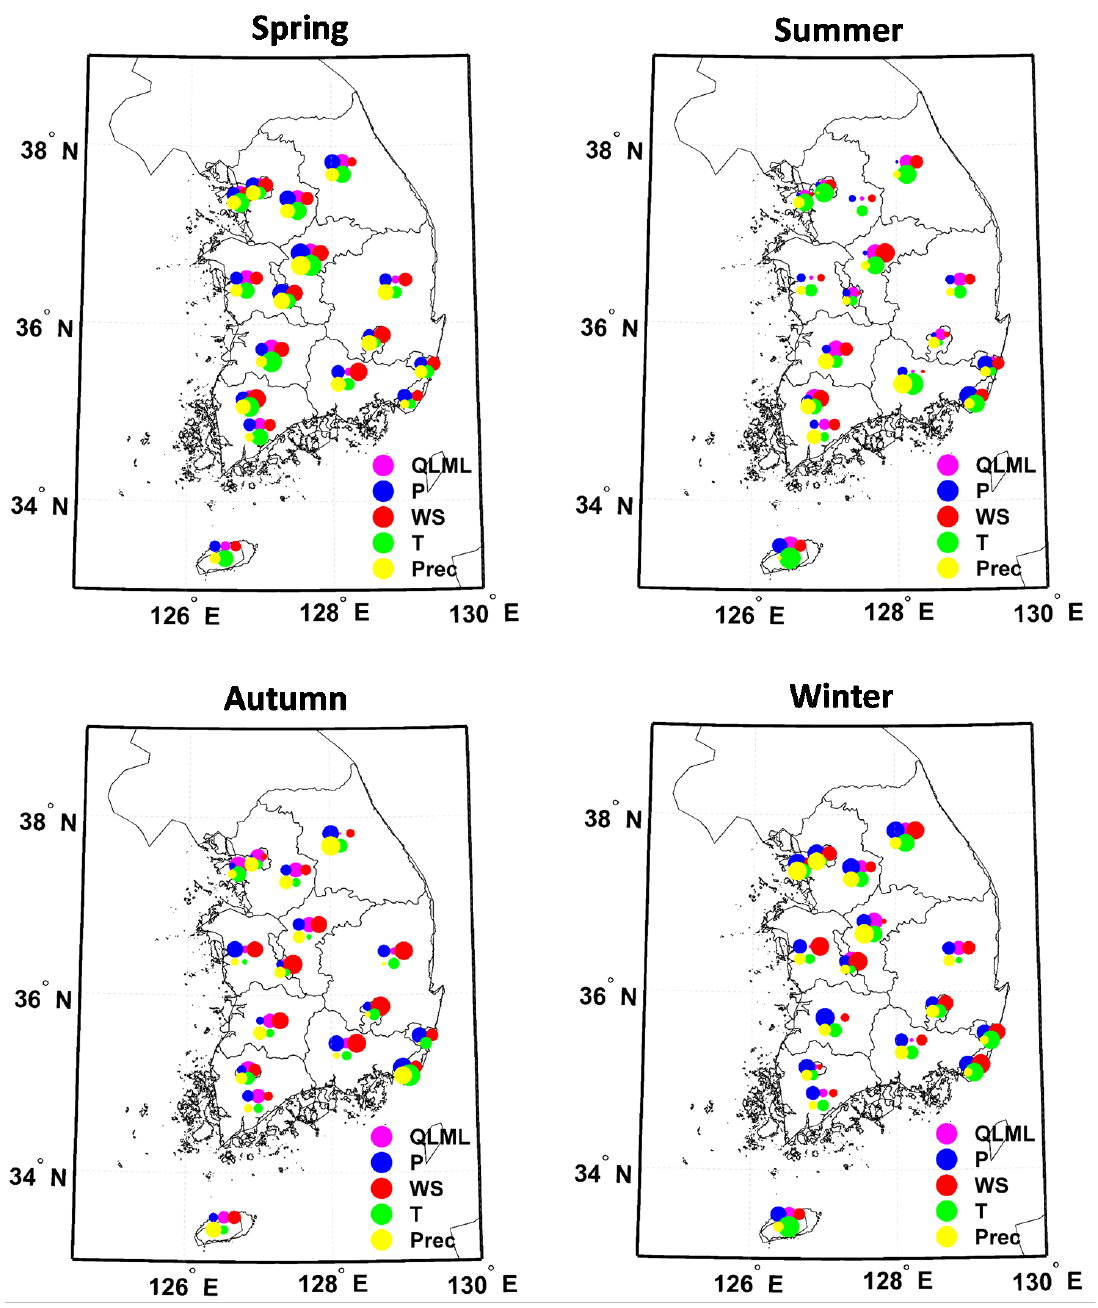
Figure 14. MLR model results between PM 10 and the meteorological parameters. The colors repre- sent the type of the meteorological parameter, and the size indicates the magnitude of the influenc- ing parameter. R 2 represents the fitting effect of the model, the F-test determines the significance of the model, and the t-test determines the significance of the independent